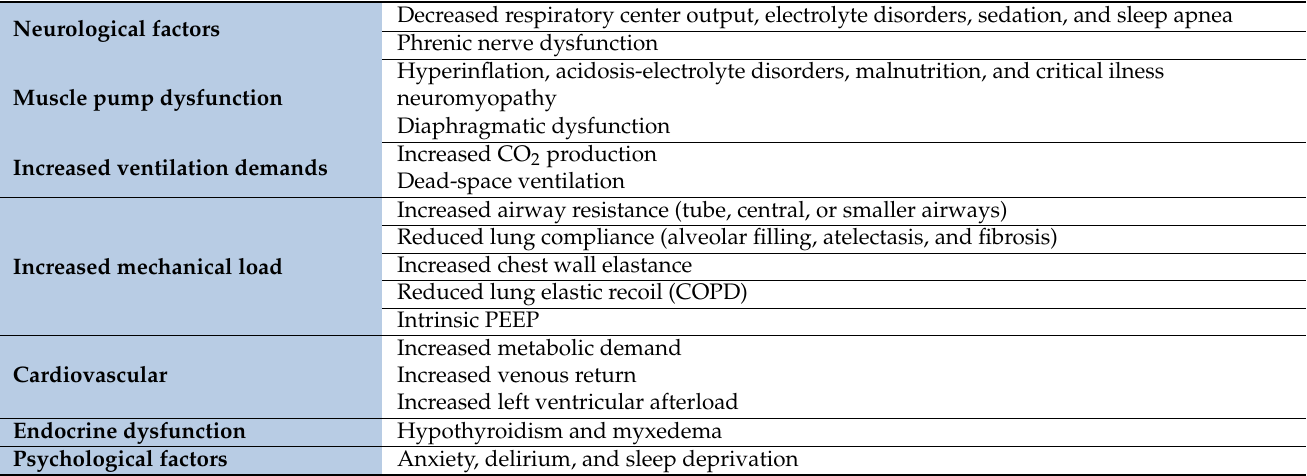
Table 3. Pathophysiologic factors associated with weaning